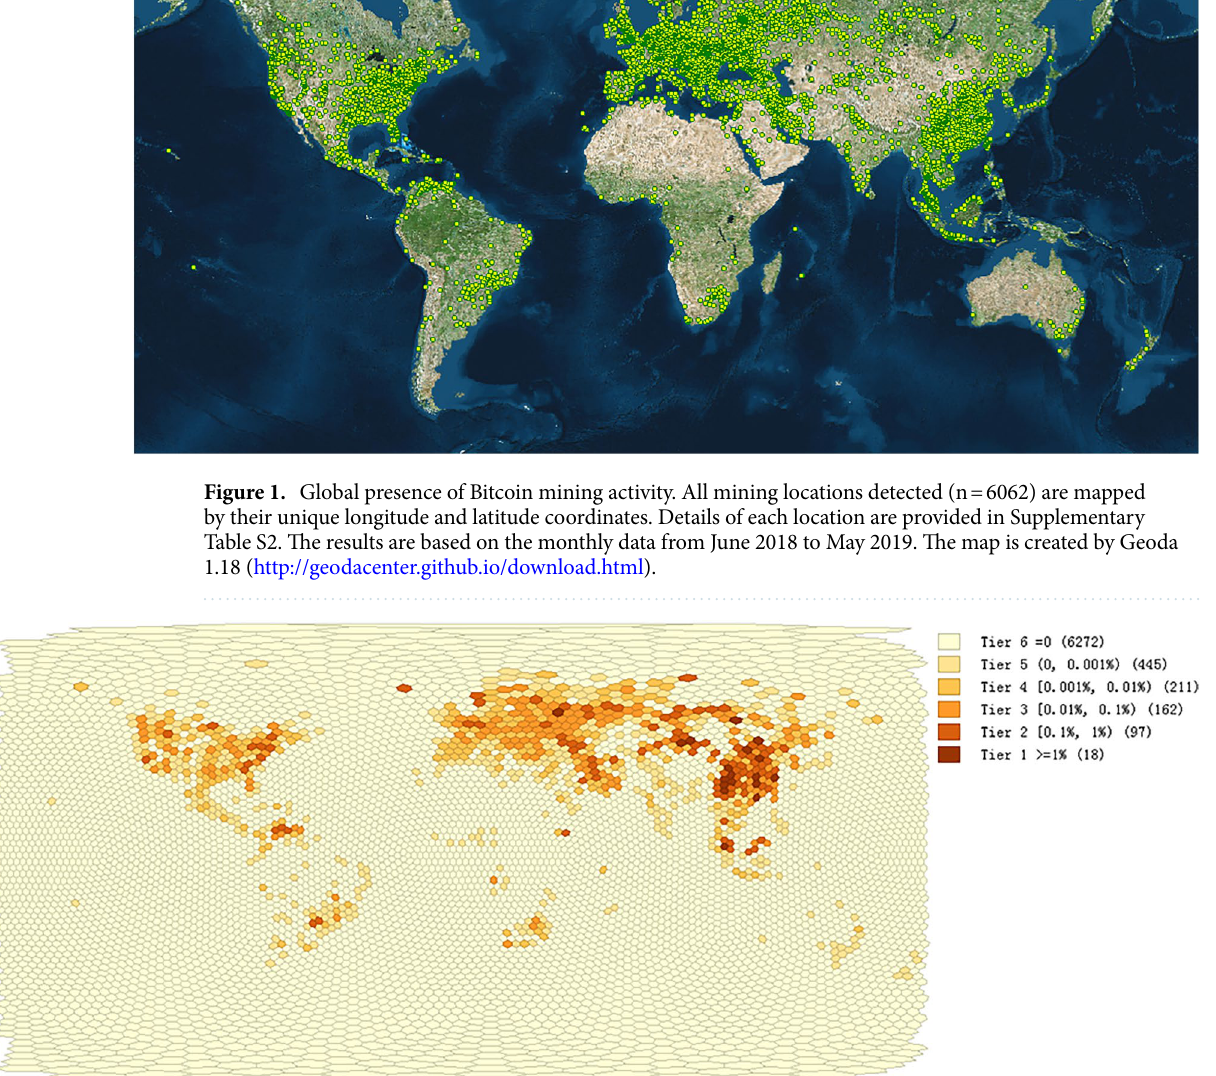
Figure 2. Share of computing power in terms of hash rate by grid. The share of computing power in each grid is represented as a percentage of total hash rates. All grids (n = 7205) are divided into six tiers with Tier 1 grids (n = 18, share of hash rate ≥ 1%), Tier 2 grids (n = 97, 1% > share of hash rate ≥ 0.1%), Tier 3 grids (n = 162, 0.1% > share of hash rate ≥ 0.01%), Tier 4 grids (n = 211, 0.01% > share of hash rate ≥ 0.001%), Tier 5 grids (n = 445, 0.001% > share of hash rate > 0) and Tier 6 grids (n = 6272, share of hash rate = 0). The results are based on the monthly data from June 2018 to May 2019. Details of the statistics are supplied in “Methods” and the repository as noted. The map is created by Geoda 1.18 (http:// geoda center. github. io/ downl oad.